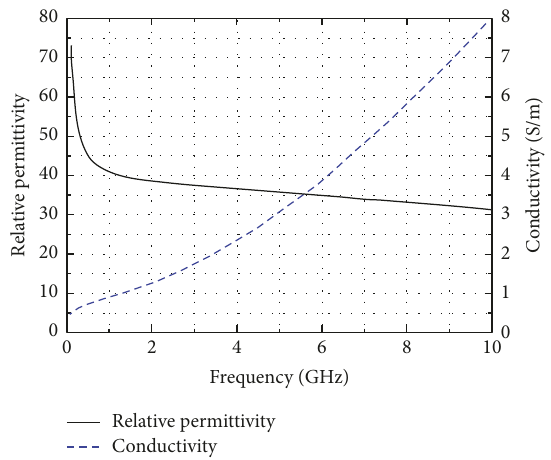
Figure 2: The dielectric properties of the skin tissue in simulation.